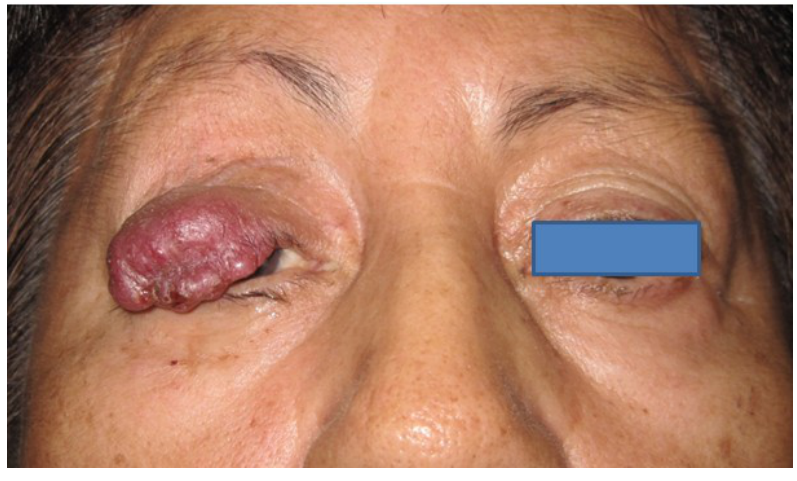
Figure 1. External photograph in a patient with typical appearance of Merkel cell carcinoma of upper